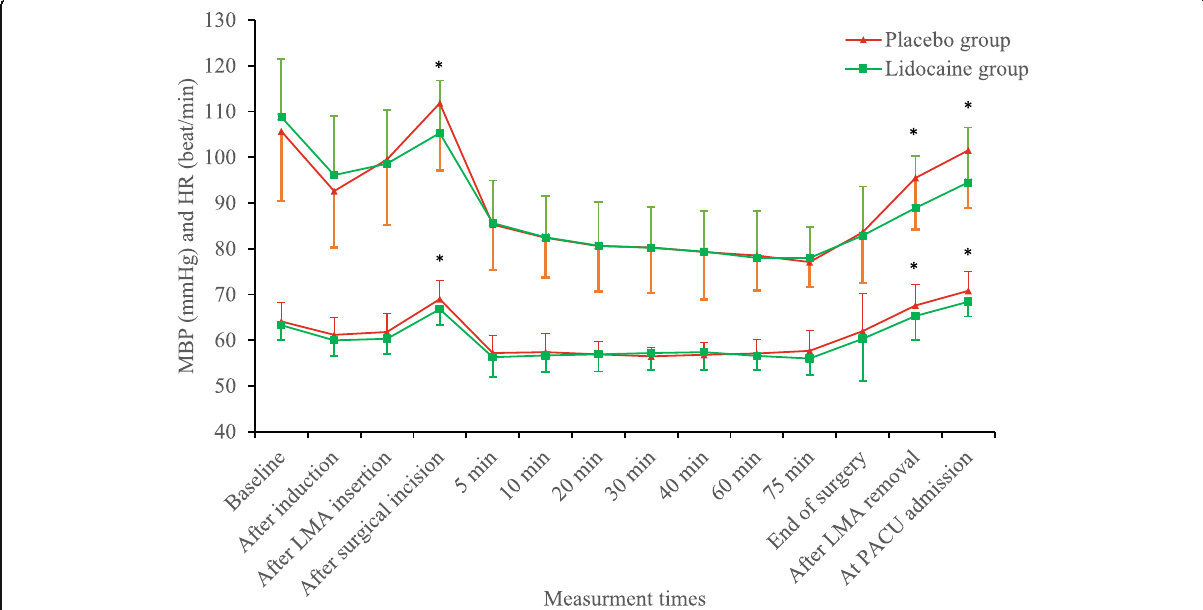
Fig. 3 The mean (SD) of MBP and HR in both groups. MBP mean arterial blood pressure, HR heart rate, and PACU post-anesthesia care unit. P < 0.05 considered significant. *Significant to the placebo